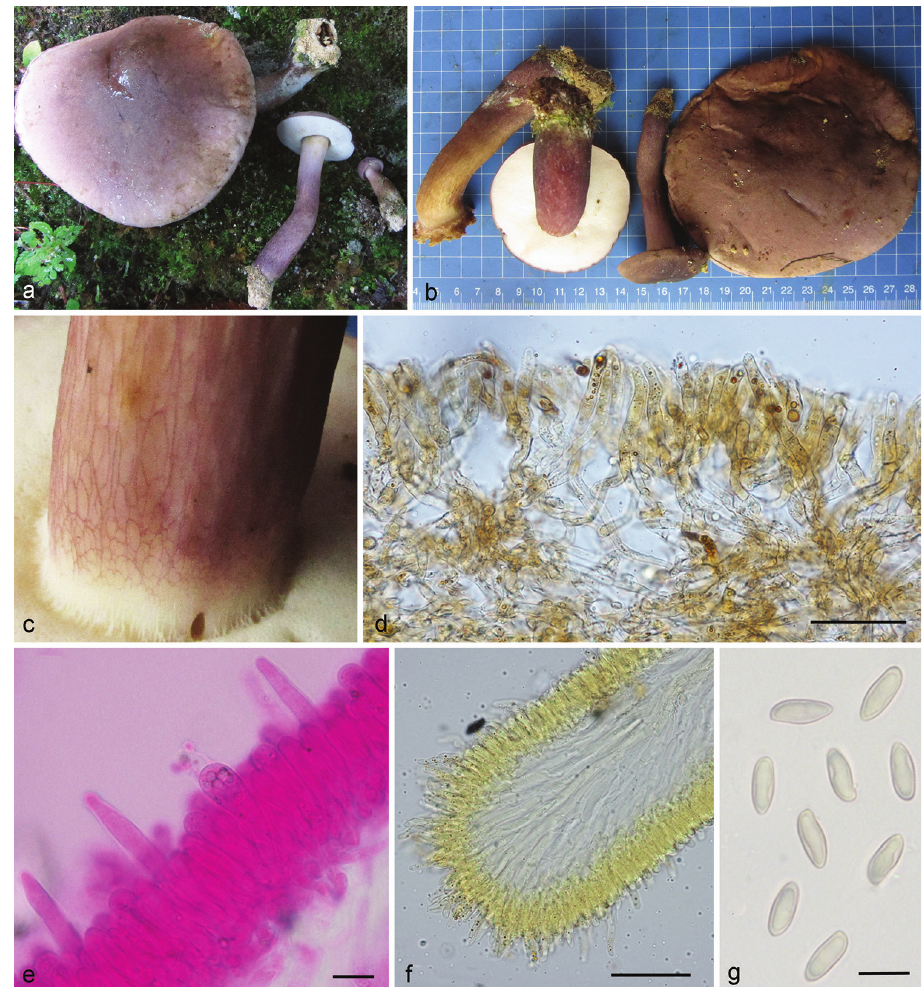
Figure 7. Tylopilus neofelleus (DC 16-63). a, b Fresh basidiomata in the field and in basecamp c Stipe surface with reticulation d Pileipellis e Hymenial layer showing basidia and pleurocystidia f Tube edge g Basidiospores. Scale bars: 50 µm ( d, f ); 10 µm ( e, g ).